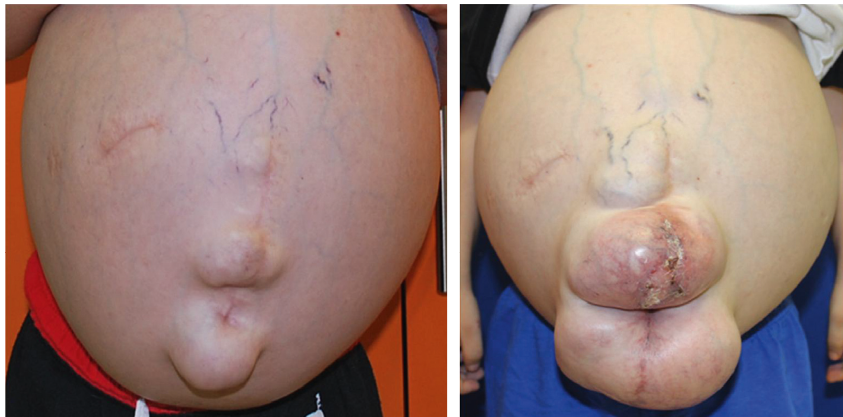
Figure 1: Abdominal enlargement: at the initial visit (June 2016) and at the last control appointment (November